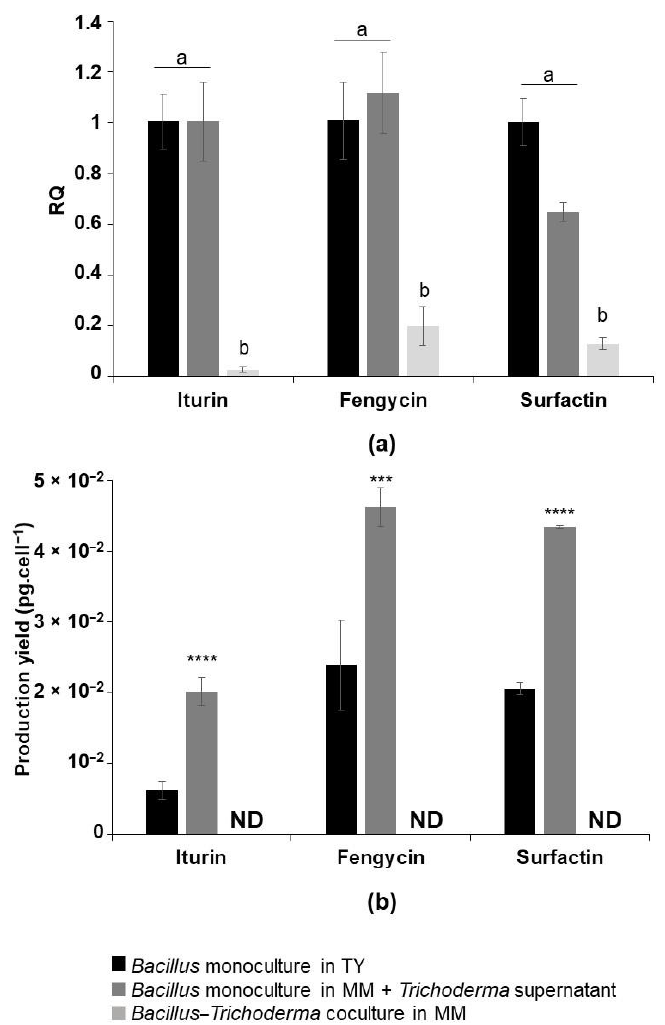
Figure 5. ( a ) Expression levels of iturin, fengycin and surfactin synthetases by RT-qPCR in monocultures of B. velezensis in TY, in MM + 90% of Trichoderma ’s supernatant and in coculture with T. harzianum in MM, expressed in relative target quantity (RQ), ( b ) The respective lipopeptides concentration in the supernatant of the previous culture conditions quantified by UPLC-MS. ND = not detected. The graph ( a ) shows the mean and standard deviation of three biological repli- cates. Different letters indicate groups of statistically different conditions (one-way ANOVA and Tukey’s HSD test (honestly significantly different); α = 0.05). The graph ( b ) shows the mean values and standard deviation from three biological replicates. Statistical significance was calculated using Student’s paired t test where *** corresponds to p < 0.001 and **** to p <